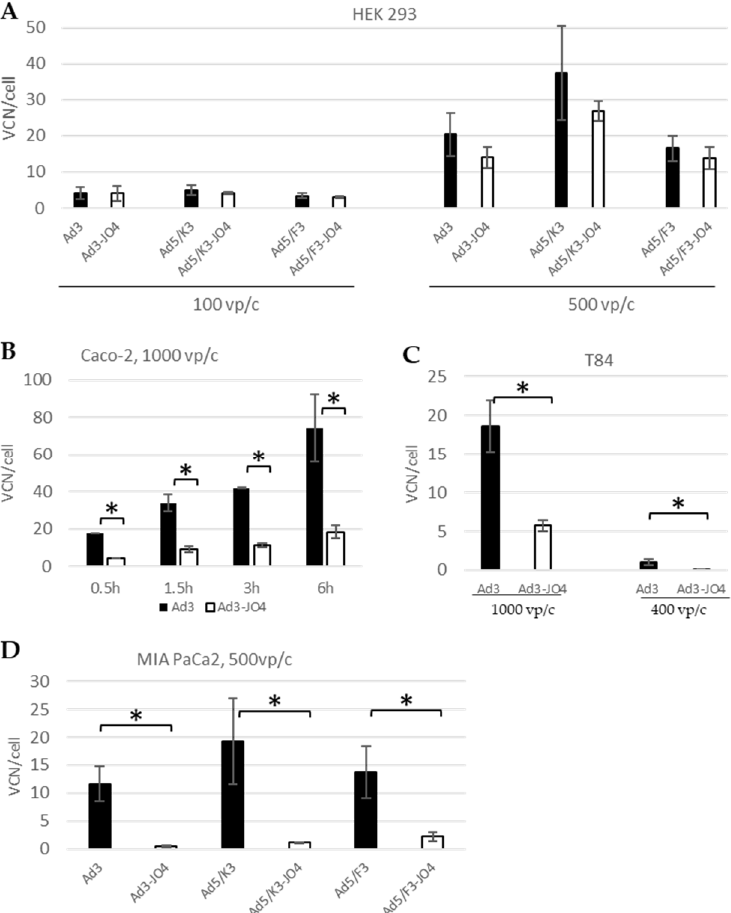
Figure 6. Virus internalization efficiency. Cells were infected with individual viruses at certain viral particles per cell (vp/c) to quantify internalized viral genome copy numbers (VCN), which were quantified by qPCR and expressed as VCN per cell. ( A ) The cell line HEK 293, in which the applied viruses were produced, ( B ) Caco-2 cells, ( C ) T84 cells and ( D ) MIA Paca-2 cells. ( A , D ) represent one of at least two independent experiments. ( B , C ) were conducted once. All experiments were conducted in four replicates (* p <